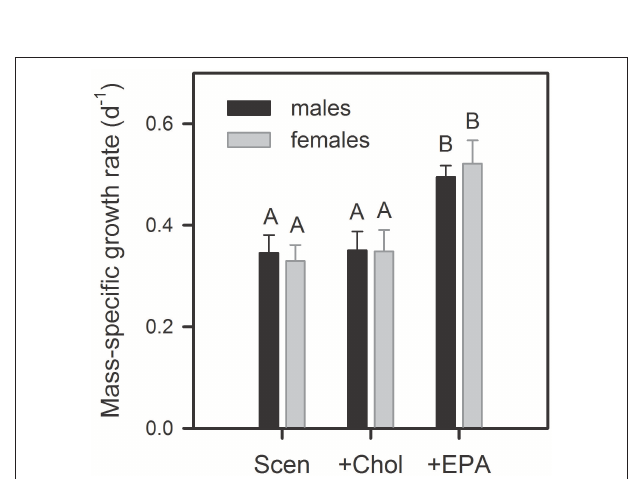
FIGURE 1 | Juvenile somatic growth responses of female and male D. magna reared on a sterol- and PUFA-free food ( Synechococcus elongatus ) supplemented with increasing amounts of cholesterol, either in the absence (A) or presence of saturating amounts of EPA (B) , or increasing amounts of EPA in the presence of saturating amounts of cholesterol (C) . Vertical lines show dietary threshold concentrations defined as a growth rate reduction of g ∞ by 25 %.